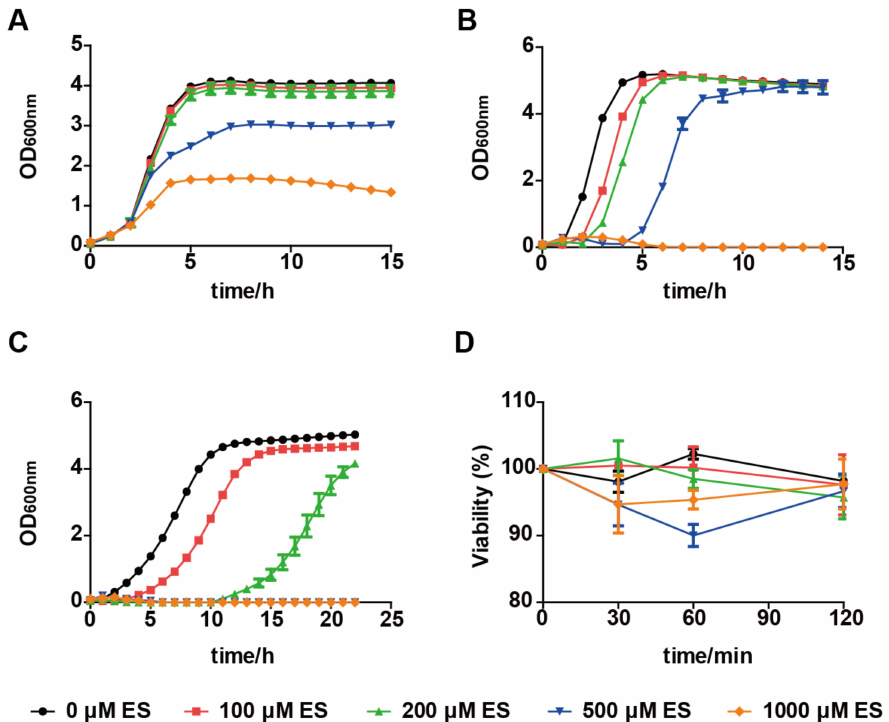
Figure 1. Characteristics of the response of E. coli , S. aureus, and S. cerevisiae to elemental sulfur. The elemental sulfur inhibited the growth of E. coli ( A ), S. aureus ( B ), and S. cerevisiae ( C ). Elemental sulfur was added to the cell cultures at the concentrations as indicated in the figure. ( D ) Survival assay for S. cerevisiae . Indicated concentrations of elemental sulfur were added to the resting cells of S. cerevisiae at an OD 600nm of 2.0. After 30, 60, and 120 min, samples were diluted and plated onto YPD plates, respectively. Colonies counting was performed after 48 h incubation at 30 ◦ C. Data are averages of three parallel experiments with standard deviations. ES, elemental